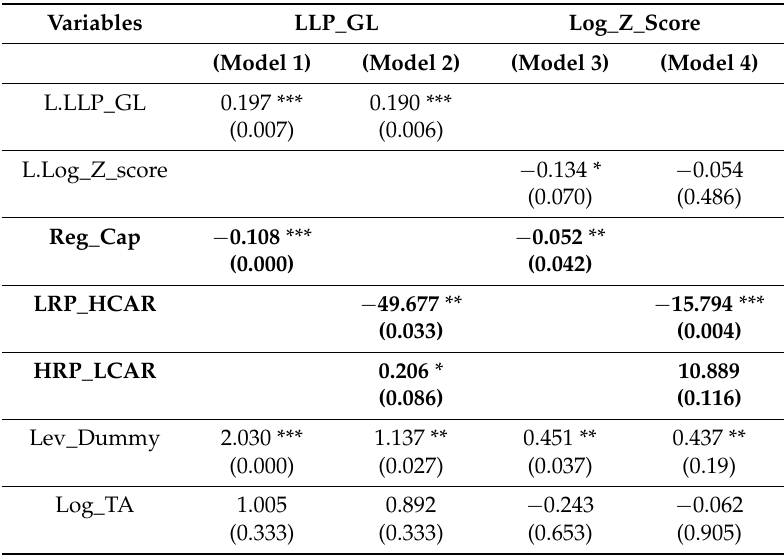
Table 6. Robustness tests: use of alternative bank risk